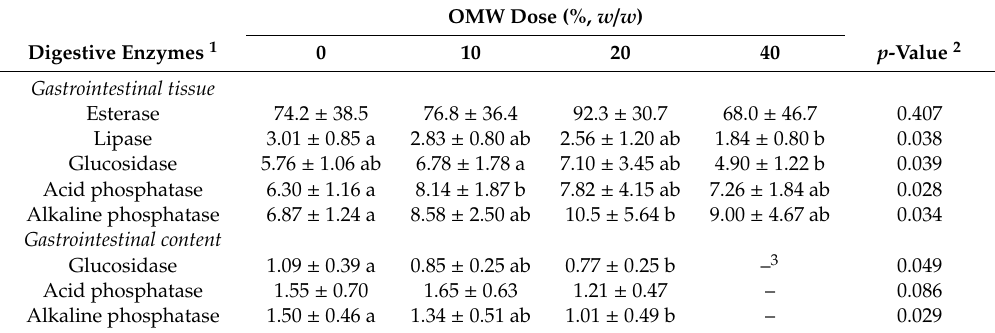
Table 2. Digestive enzyme activities (mean ± SD, n = 15) in the gastrointestinal tissue and content of Lumbricus terrestris exposed to olive mill waste (OMW)-amended soils.